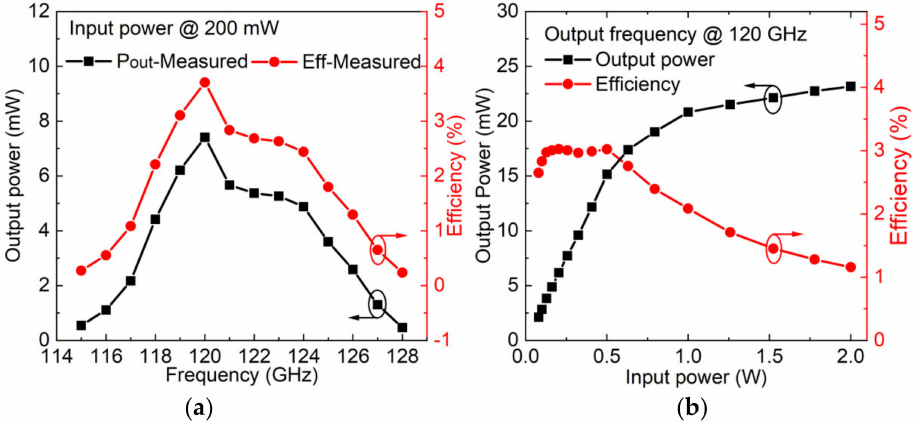
Figure 9. Measurement results of 120 GHz frequency-doubler module. ( a ) Measured output power and efficiency. ( b ) Measured output power and efficiency.